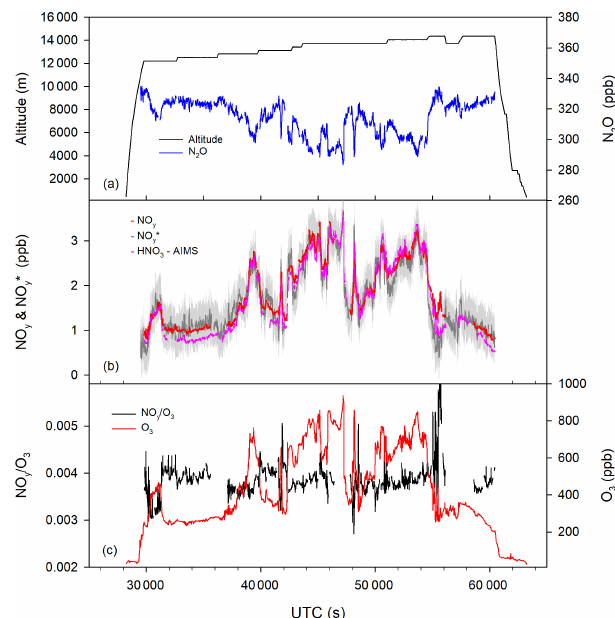
Figure 1. PGS flight 5 on 21 December 2015. (a) Altitude and N 2 O; (b) NO y (observed), NO ∗ y (calculated), and HNO 3 (AIMS instrument). The uncertainty range arising from the calculation of NO ∗ y is shaded in grey. (c) NO y / O 3 ratio and O 3 .